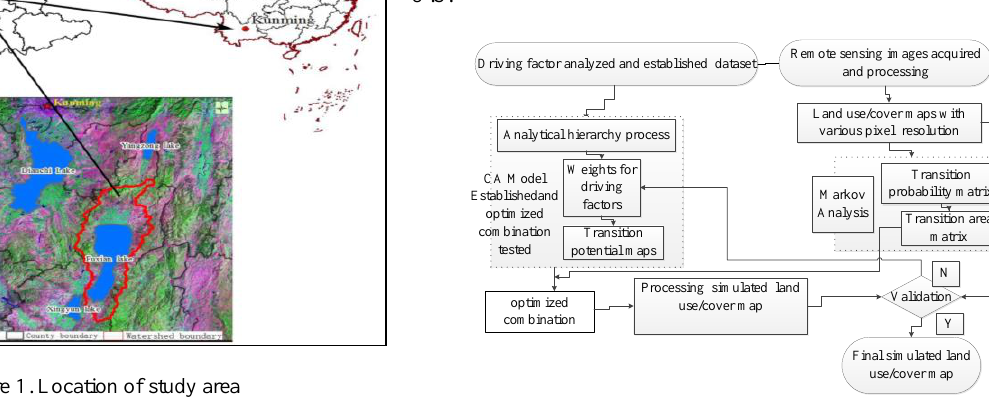
Figure 1. Location of study area